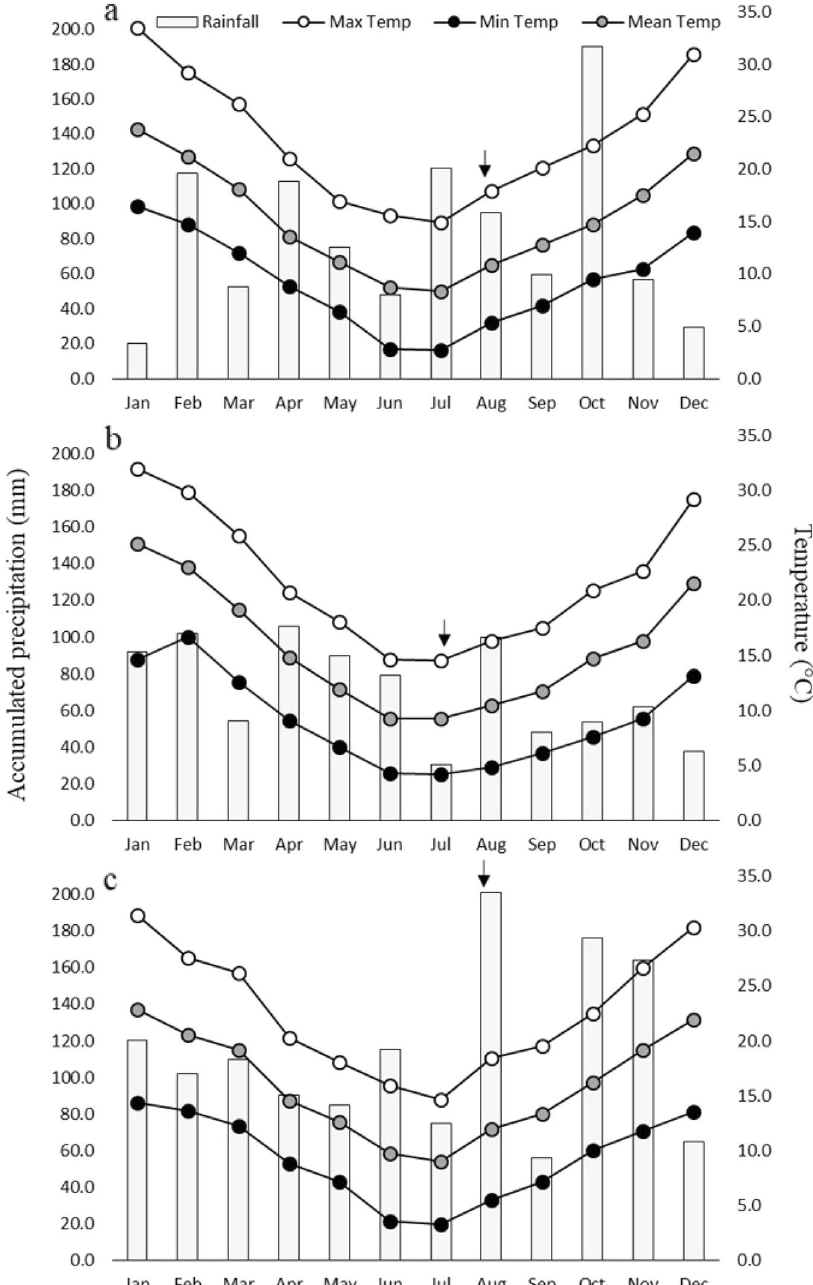
Figure 2. Accumulated precipitation and maximum, minimum and mean temperatures in three experimental environments of the Buenos Aires Province, Argentina ( a CA14, b BW17 and c PS14). Arrows indicate sowing